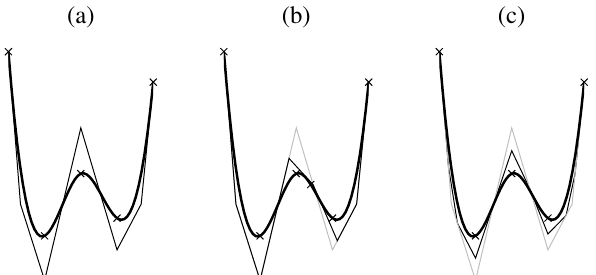
Figure 2. Refining the control polygon brings the control polygon closer to the spline: (a) the original spline, (b) one knot insertion and (c) elevate order by one. Note that knot insertion acts locally, while order elevation changes the control polygon